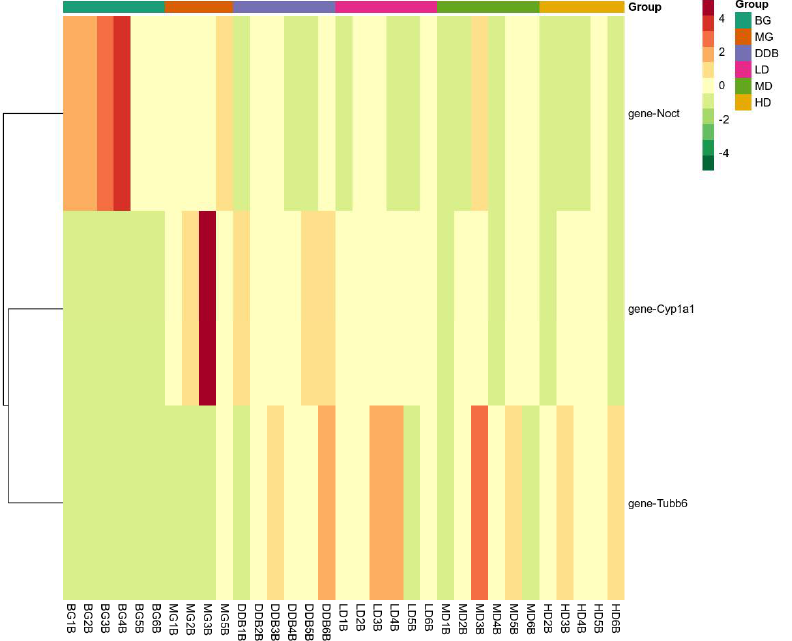
Figure 11. Heat map. The x-axis represents groups, and the y-axis represents differentially ex- pressed genes. Data (peak areas) were normalized between −4 and 4 (green—the lowest level; red— the highest level).